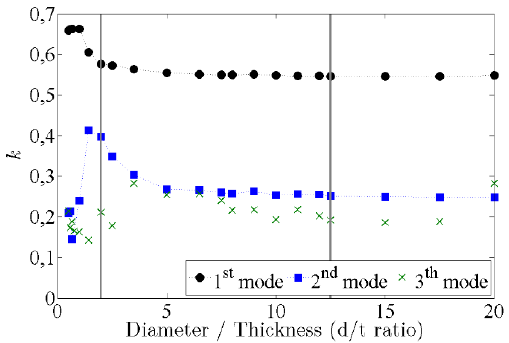
Figure 4. Results of the electromechanical coupling coefficients k from FEM simulations for the extensional vibration modes. The vertical lines indicate the selected ceramics for our studies.